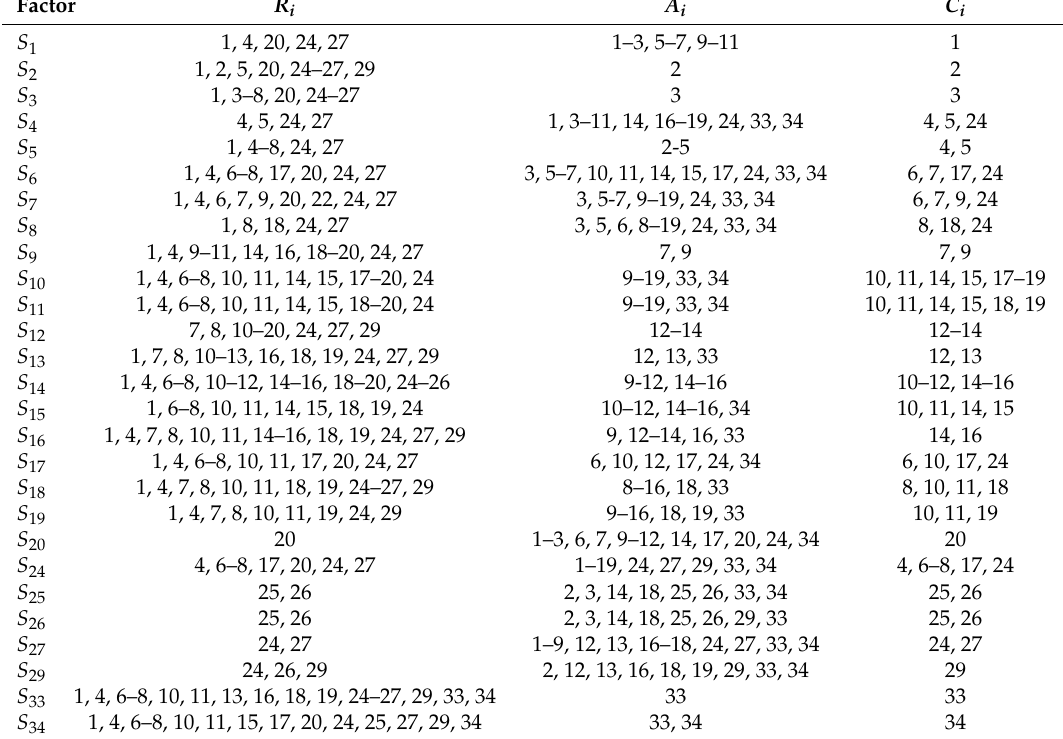
Table 6. Reachable set, antecedent set and collective set of each factor in the second round.